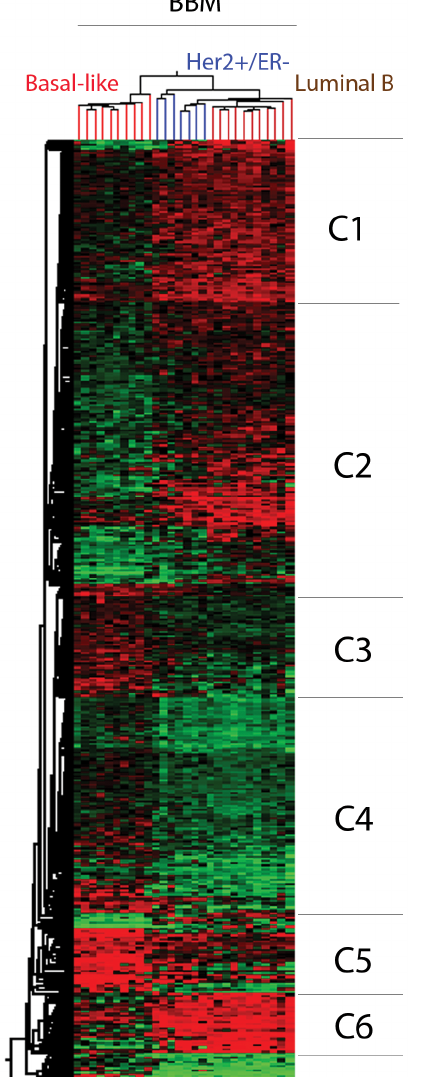
Figure 3. Hierarchical Clustering of Genes that Differentiated Brain Metastases Based on Their Breast Cancer Intrinsic Subtype Status. Six distinct clusters were identified and their respective genes further